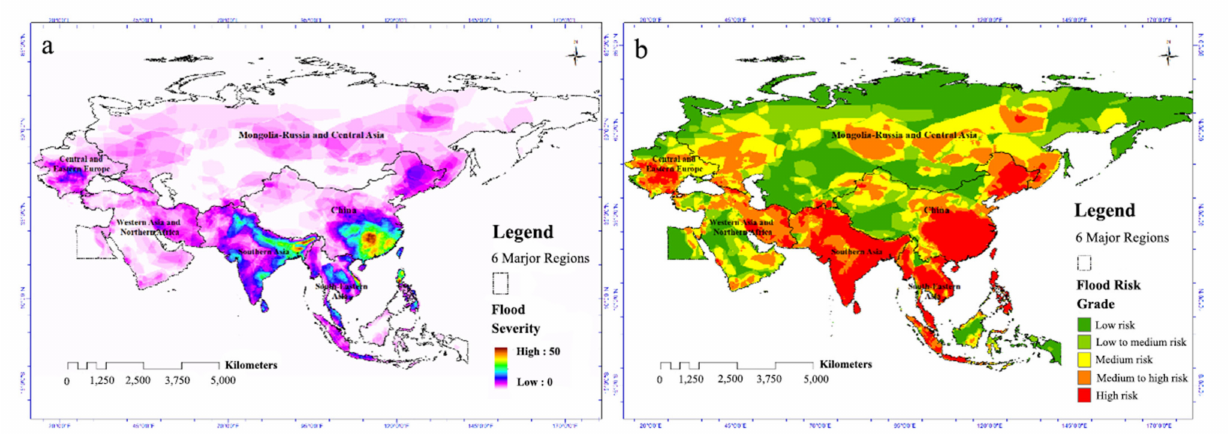
Figure 5. ( a ) flood frequency map along the “Belt and Road” zone; ( b ) flood frequency hierarchical map.